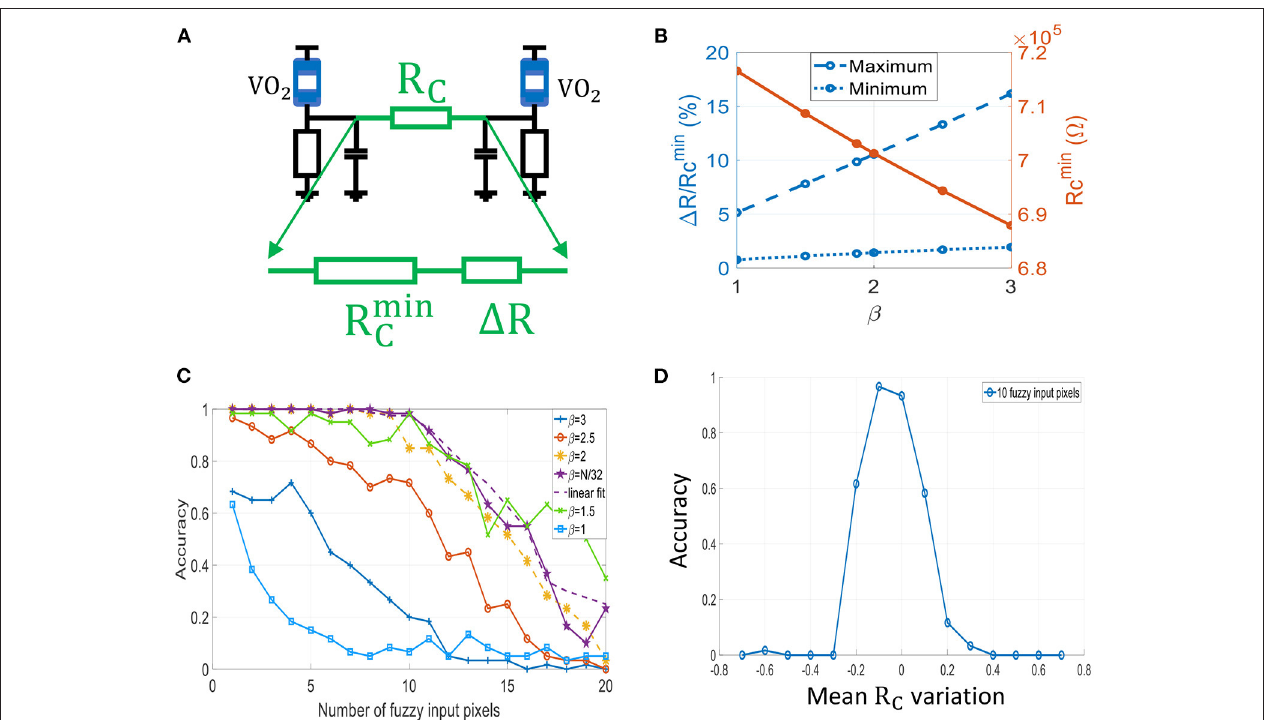
FIGURE 14 | (A) Two oscillators coupled by R C , which can be decomposed in two series resistances: R C = R min C + 1 R . (B) Evolution of 1 R , R min C with respect to β . 1 R max ≈ 10 % R min C gives the best accuracy results. Note that 1 R min = 1.7 % R min C . (C) ONN recognition accuracy for different values of β . The dashed line is obtained for a linear fit of the mapping µ N , i.e., with coupling resistances that are linearly spaced. (D) Impact of R C ’s mean variation on recognition